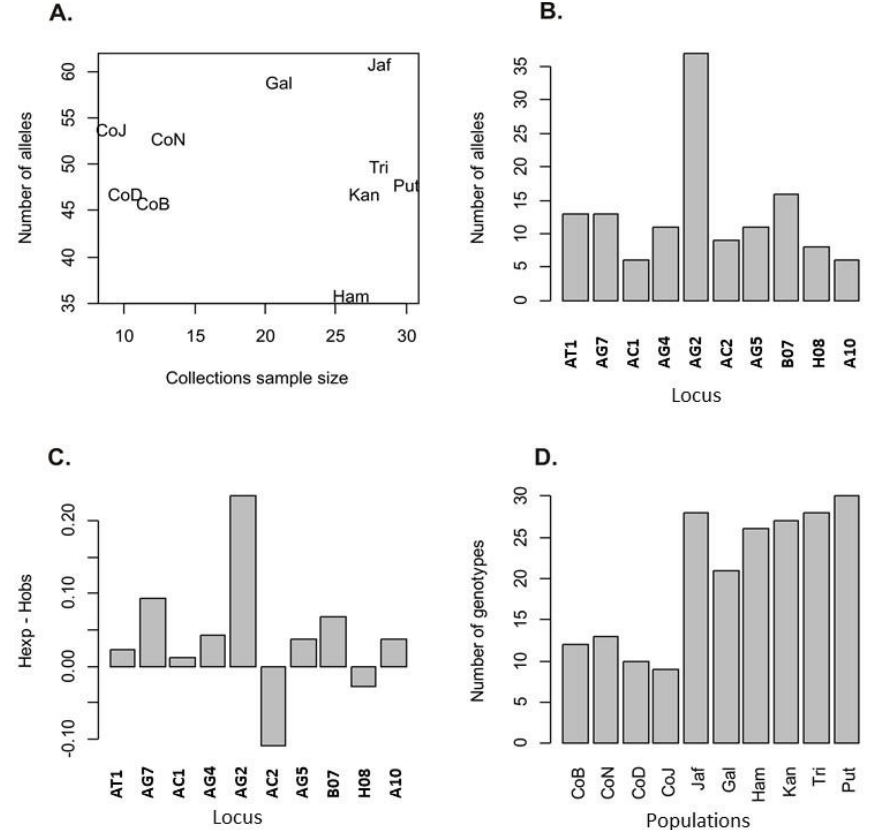
Figure 2. ( A ) The relationship between the number of alleles recorded in Aedes aegypti and collection sample size. ( B ) The number of alleles per locus. ( C ) The differences between expected and observed heterozygosity and sample size in each collection. ( D ) Sample size in each collection.